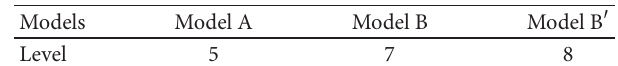
Figure 2: Structure of DHNN. Table 7: Level result of every model.